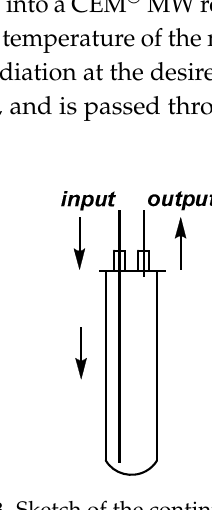
Figure 3. Sketch of the continuous flow cell.